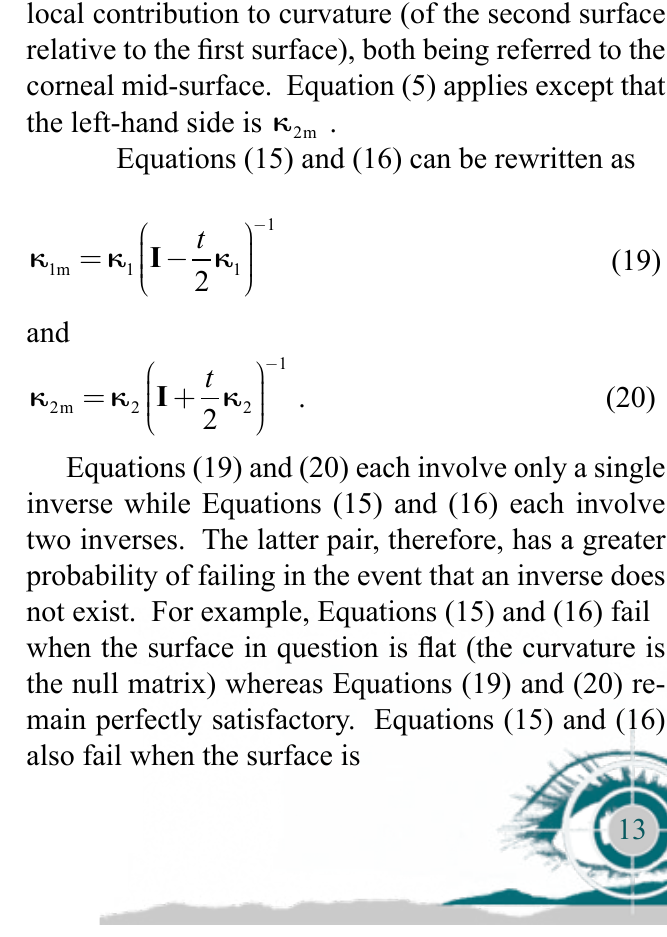
Figure 1 A cornea represented by its anterior and posterior surfaces S anterior and posterior surfaces respectively and r